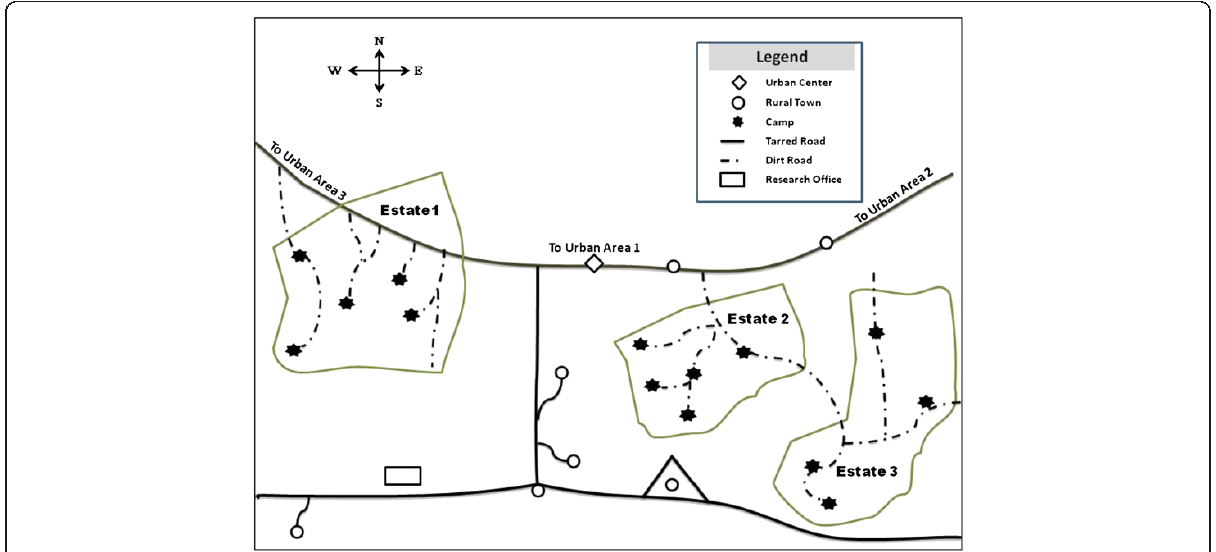
Figure 1 Ethnographic map of 3 plantation estates in Cameroon, August-October